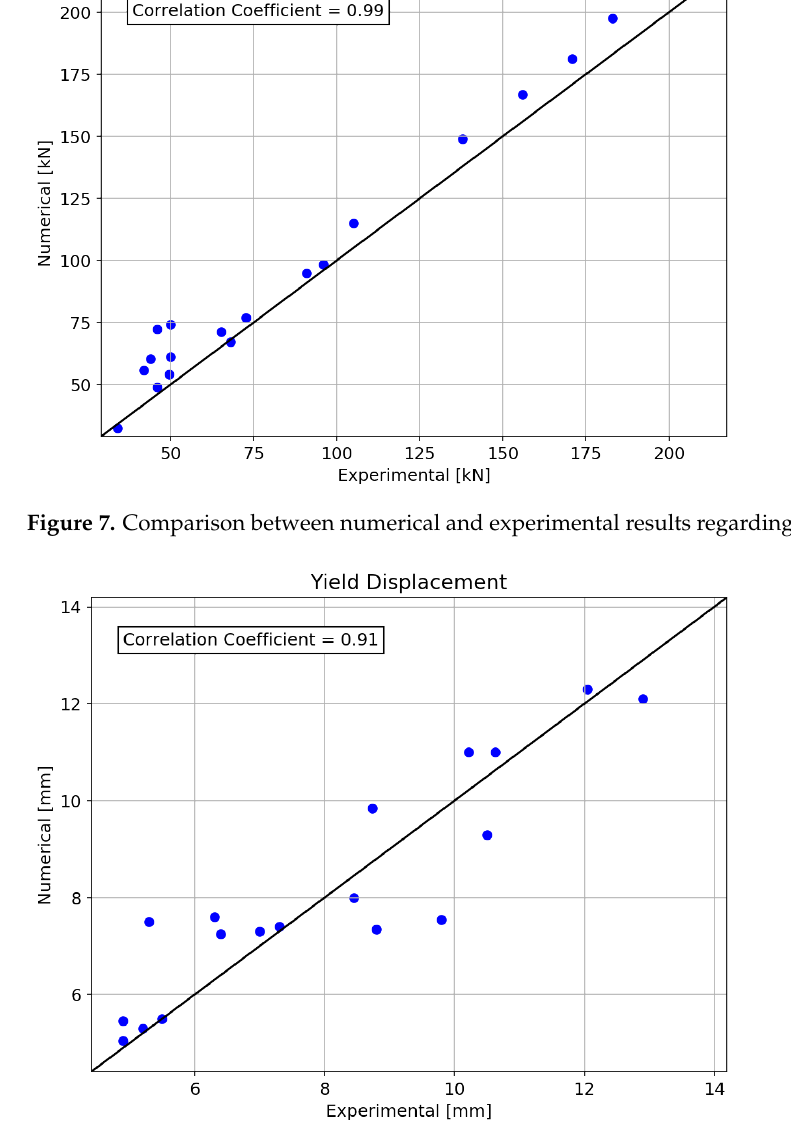
Figure 8. Comparison between numerical and experimental results regarding yield